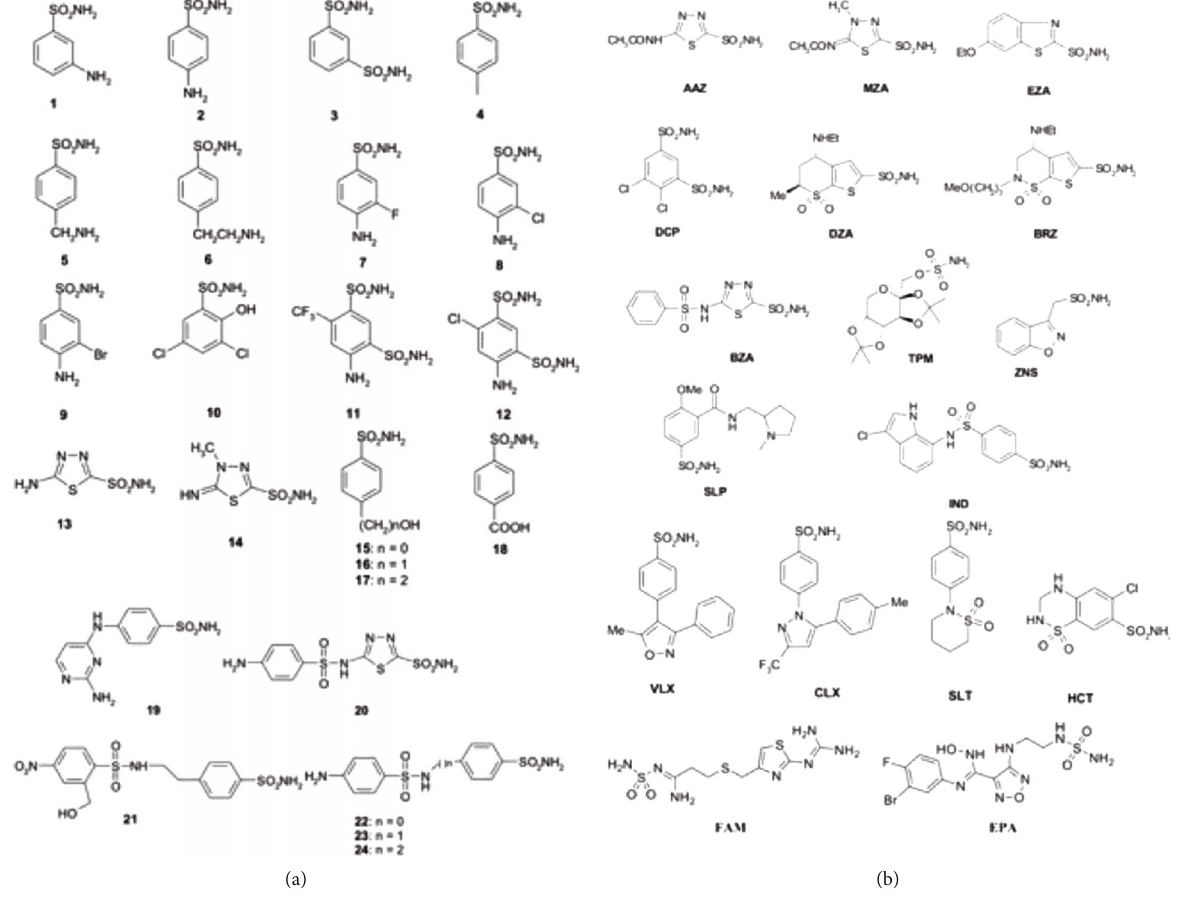
Figure 2: Sulfonamides and their isostere classes (sulfamates and sulfamides) as CAIs. Simple aromatic/heterocyclic derivatives 1-24 (a); clinically used drugs or agents in clinical development (b). Legend: AAZ: acetazolamide; MZA: methazolamide; EZA: ethoxzolamide; DCP: dichlorophenamide; DZA: dorzolamide; BRZ: brinzolamide; BZA: benzolamide; TPM: topiramate; SLT: sulthiame; ZNS: zonisamide; SLP: sulpiride; IND: indisulam; CLX: celecoxib; VLX: valdecoxib; HCT: hydrochlorothiazide; FAM: famotidine; EPA: